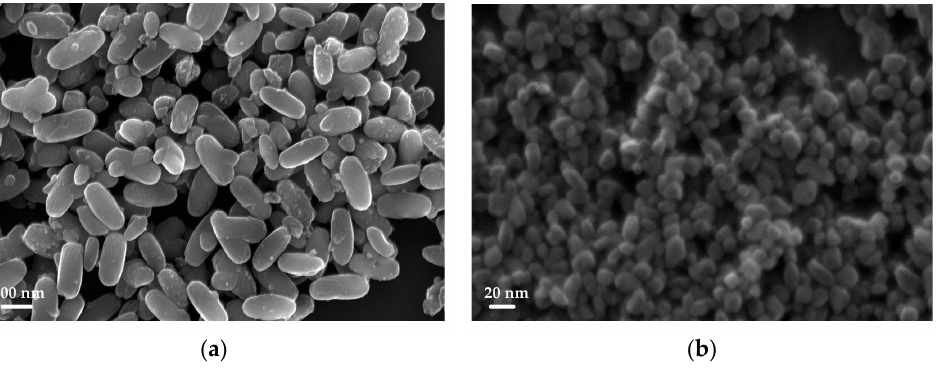
Figure 7. SEM images of TP22.10 ( a ) and TP25.5 ( b ). At higher dilutions ( r ≤ 4.15, TP22.10) the formation of larger nanoparticles was favored, with hydrolysis and condensation occurring more slowly in this case; a slow nucleation of a few nuclei is hypothesized to occur with different sizes incorporating other nuclei during the hydrothermal treatment. The results obtained in terms of shape and size were similar to those obtained with the glycol synthesis.